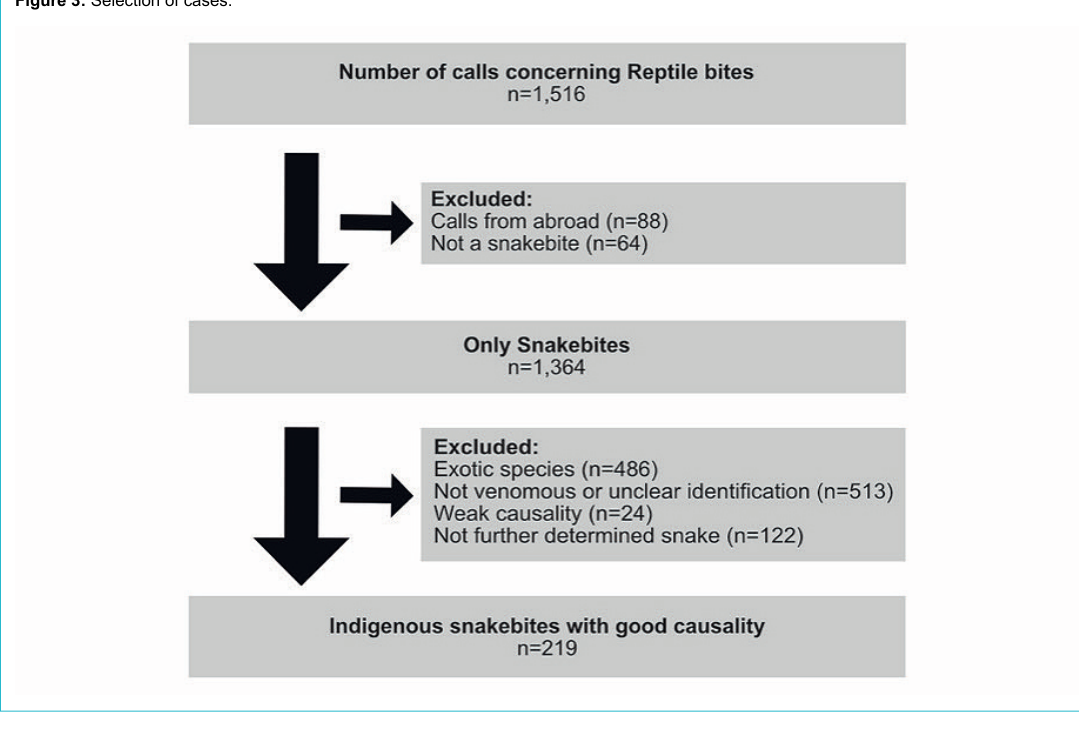
Figure 3: Selection of cases.